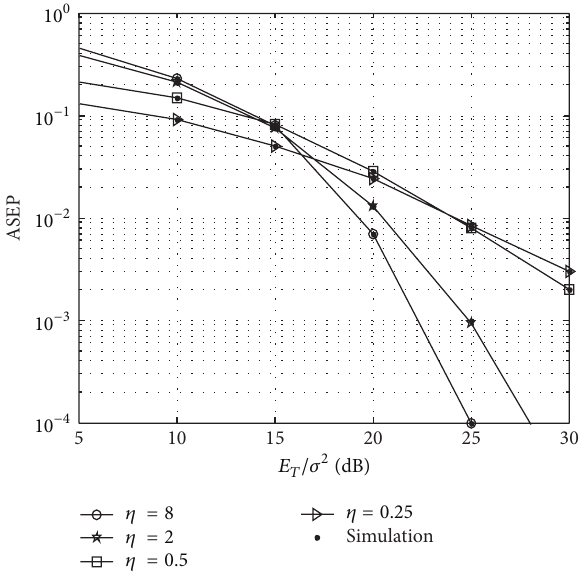
Figure 3: ASEP of 2 × 2 MIMO system for 16-QAM using MMSE- OSIC detection over Weibull fading channel ( 𝑘 = 5 ) with arbitrary values of 𝜂